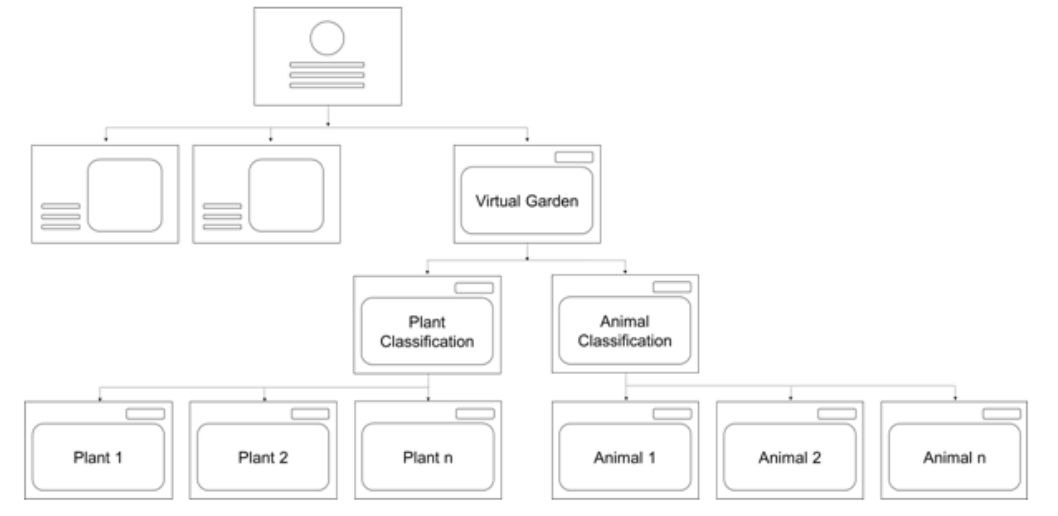
Figure 2. Wireframe of Interactive Virtual